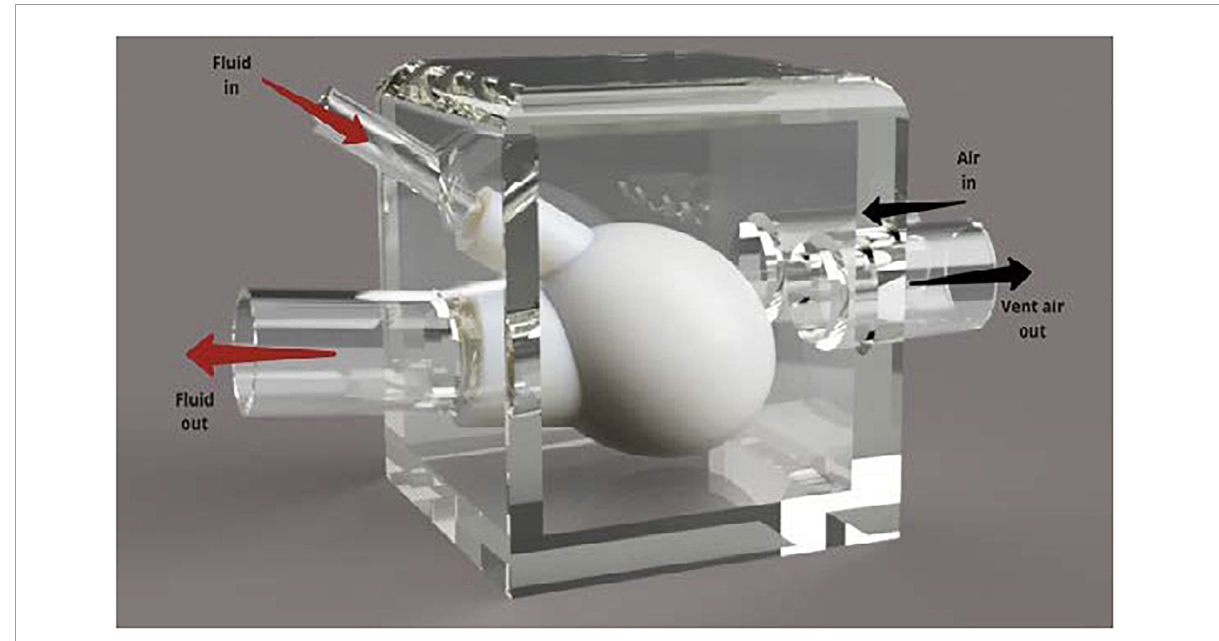
FIGURE3 Annotated render of the silicone heart chamber inside a Tupperware container. The rigid plastic container was used to redirect the pressurized air to compress the heart chamber during systole.